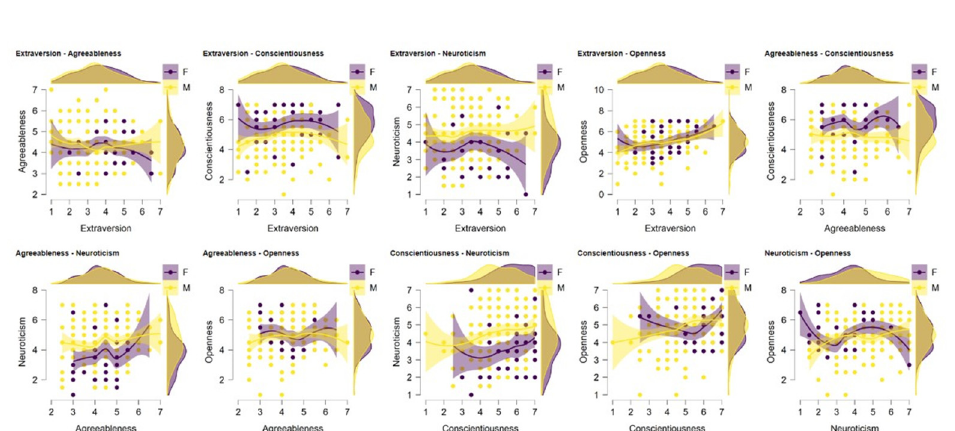
Figure 1. Scatter plot between gender-separated personality traits.